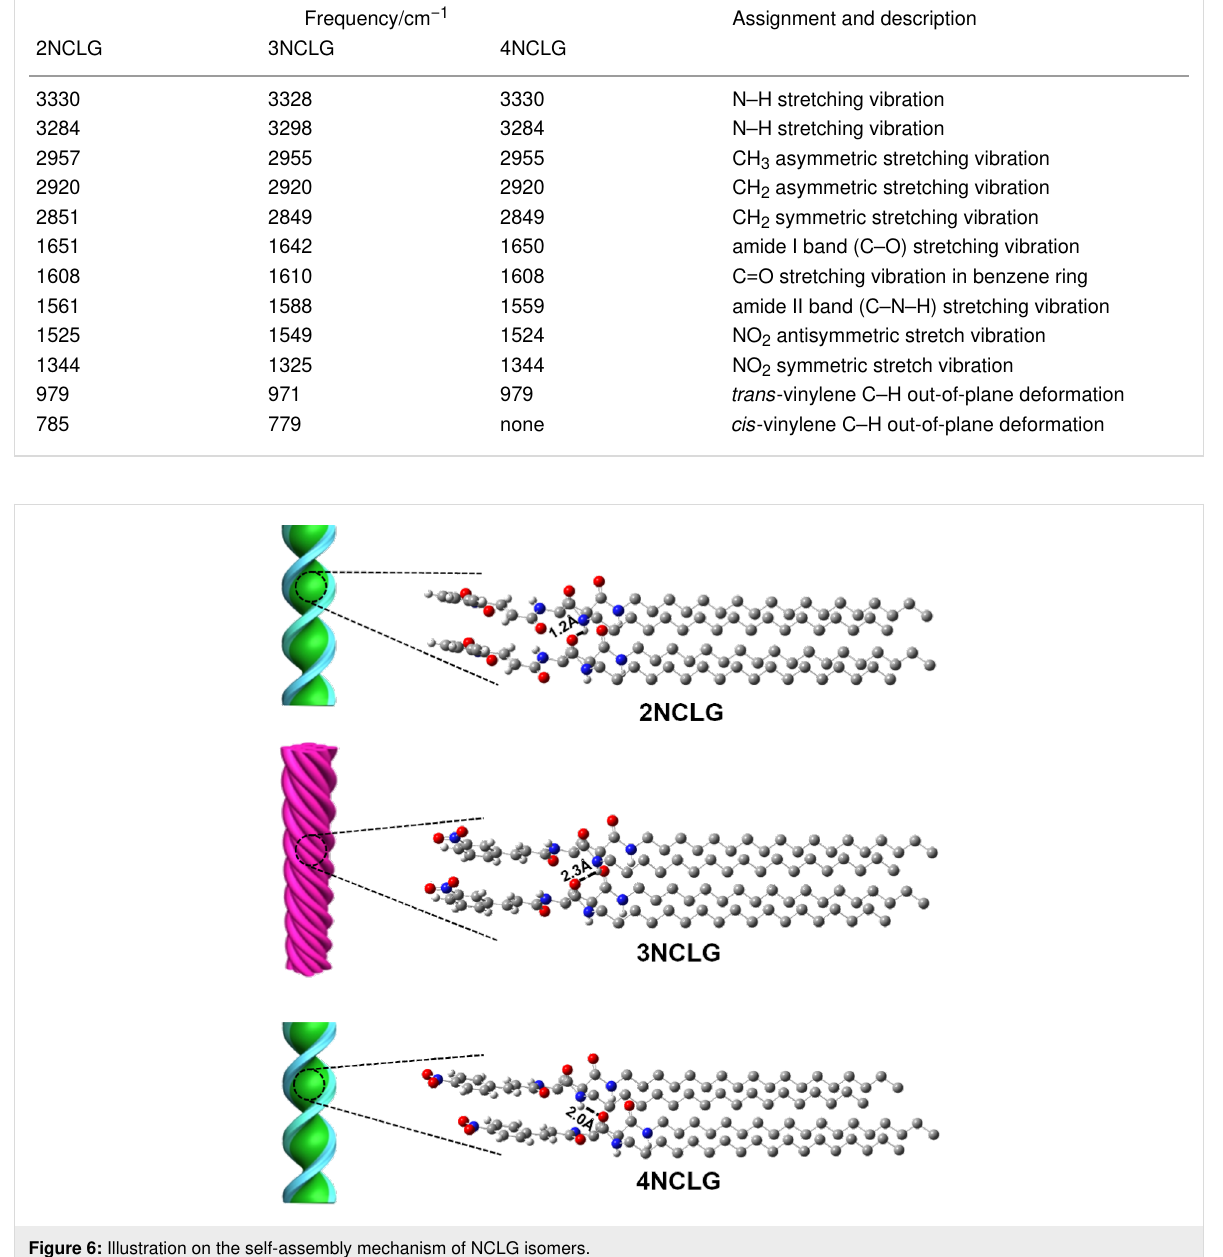
Figure 6: Illustration on the self-assembly mechanism of NCLG isomers.